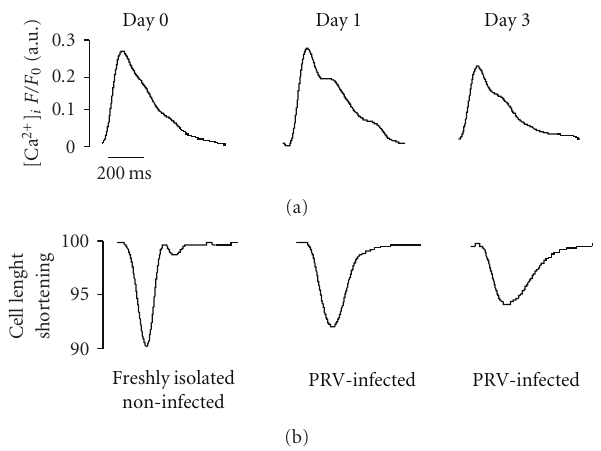
Figure 5: Original Ca 2+ transients and cell contraction recording in cardiomyocytes cultured for 1 and 3 days. The top panel shows the intracellular Ca 2+ concentration as Ca 2+ transient fluorescent signal (F535nm), and bottom panel shows the changes in cell